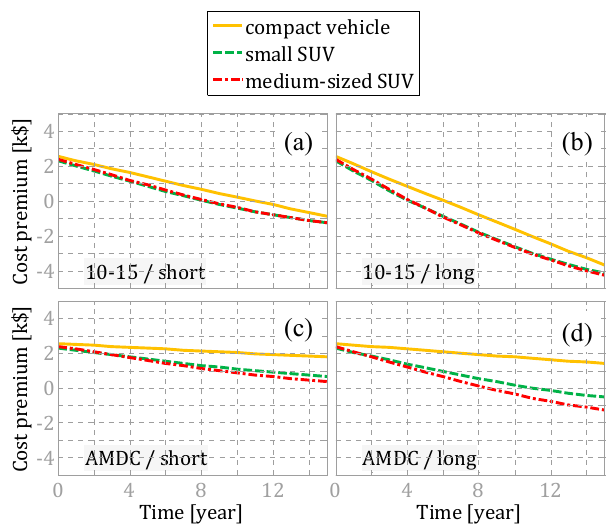
Figure 7. Cost premium for the compact vehicle (solid yellow line), small SUV (dashed green line) and medium-sized SUV (dashed-dotted cyan line) over their lifetimes, over the 1015 ( a , b ) and AMDC ( c , d ) missions for a short ( a – c ) and long ( b – d ) VKT.